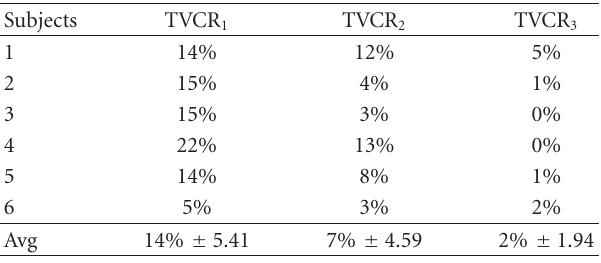
Figure 10: Tissue volume change ratio over di ff erent phases for five lobes average across six subjects. Table 3: Statistics of whole lung tissue volume change ratio TVCR 1 , TVCR 2 , and TVCR 3 for each subject and averaged over six